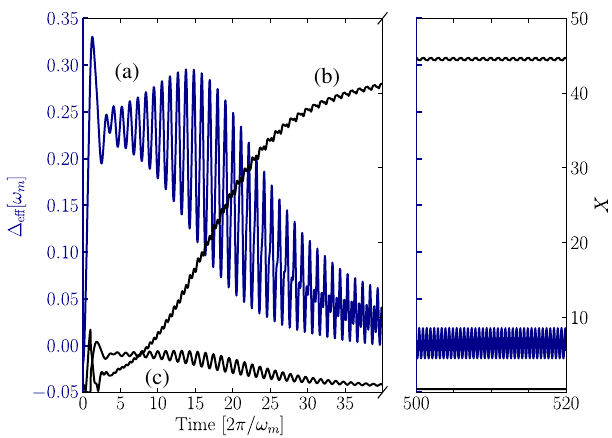
FIG. 3 (color online). Example of the oscillator time evolution for the classical equations of motion [see Eq. (46)], with initial r ¼ 0 Þ > 0 . (a) Effective condition r ¼ 0 for Δ ≲ 0 but Δ eff ð t Þ with a scale on the left (blue) axis, (b) oscillator detuning Δ eff ð amplitude r ð t Þ , and (c) dc shift in position with a scale on the right (black) axis. A positive effective detuning at r ≈ 0 ensures that the limit cycle starts. With increasing oscillator amplitude, P the intracavity photon number j α n j 2 from Eq. (27) drops, n and hence also Δ . As μ ∝ Δ [see Eq. (41)], the oscillator eff eff 0 . settles into the steady state as soon as this drop reaches Δ eff ¼ 2 κ ; γ 2 γ Þ ¼ The parameters in this plot are ð E; g 0 ; κ E ¼ E ¼ ð 4 . 0 ; 0 . 05 ; 0 . 3 ; 2 × 10 − 5 Þ × ω m